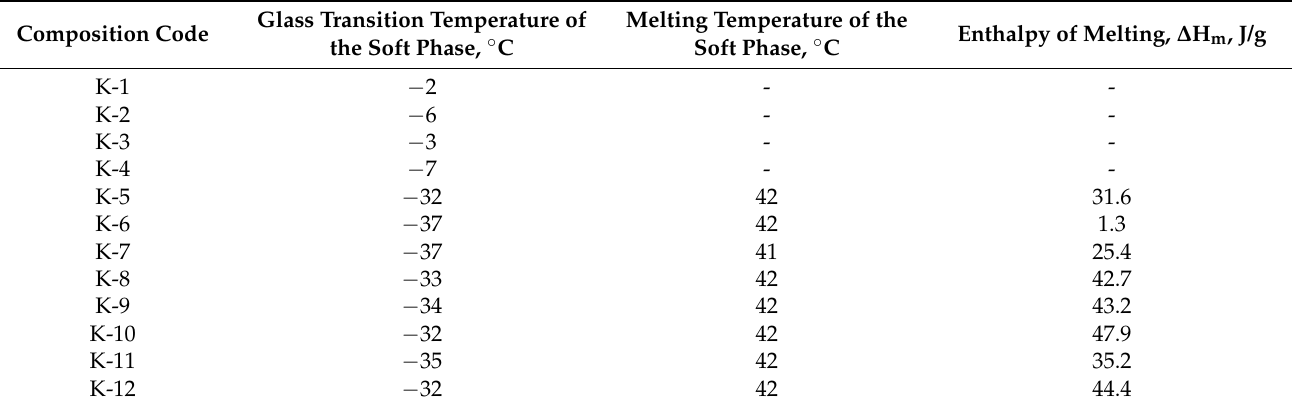
Table 4. Thermophysical properties of synthesized